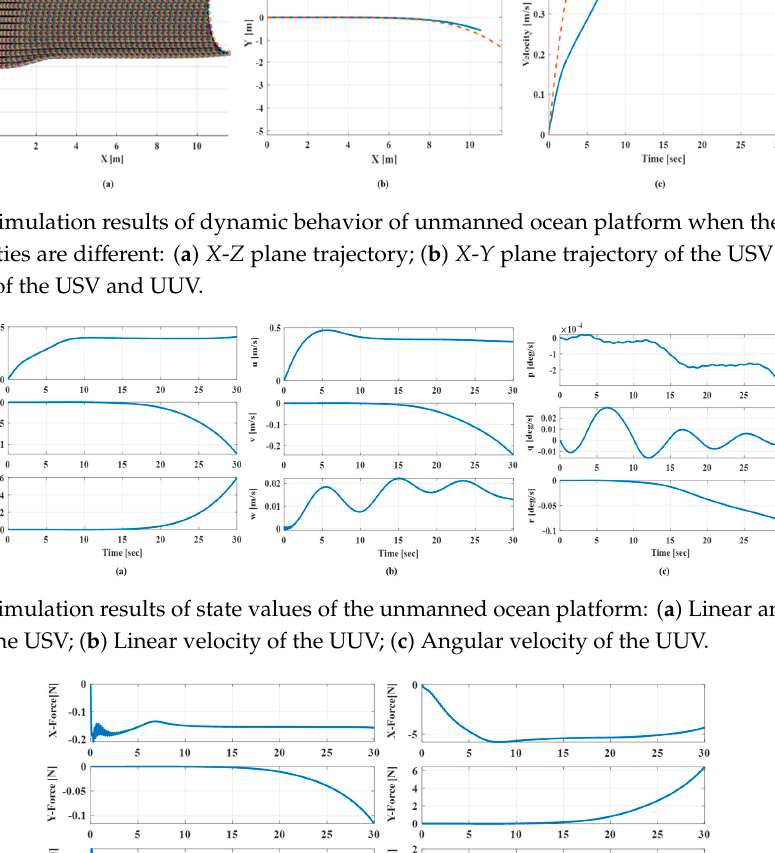
Figure 22. Simulation results of dynamic behavior of unmanned ocean platform when the USV and UUV velocities are different: ( a ) X - Z plane trajectory; ( b ) X - Y plane trajectory of the USV and UUV; ( c ) Velocity of the USV and UUV.